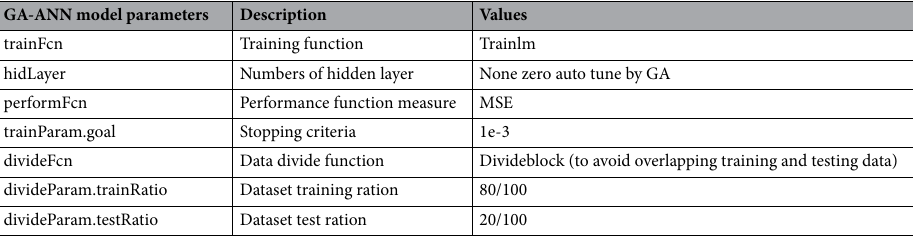
Table 2. GA-ANN model